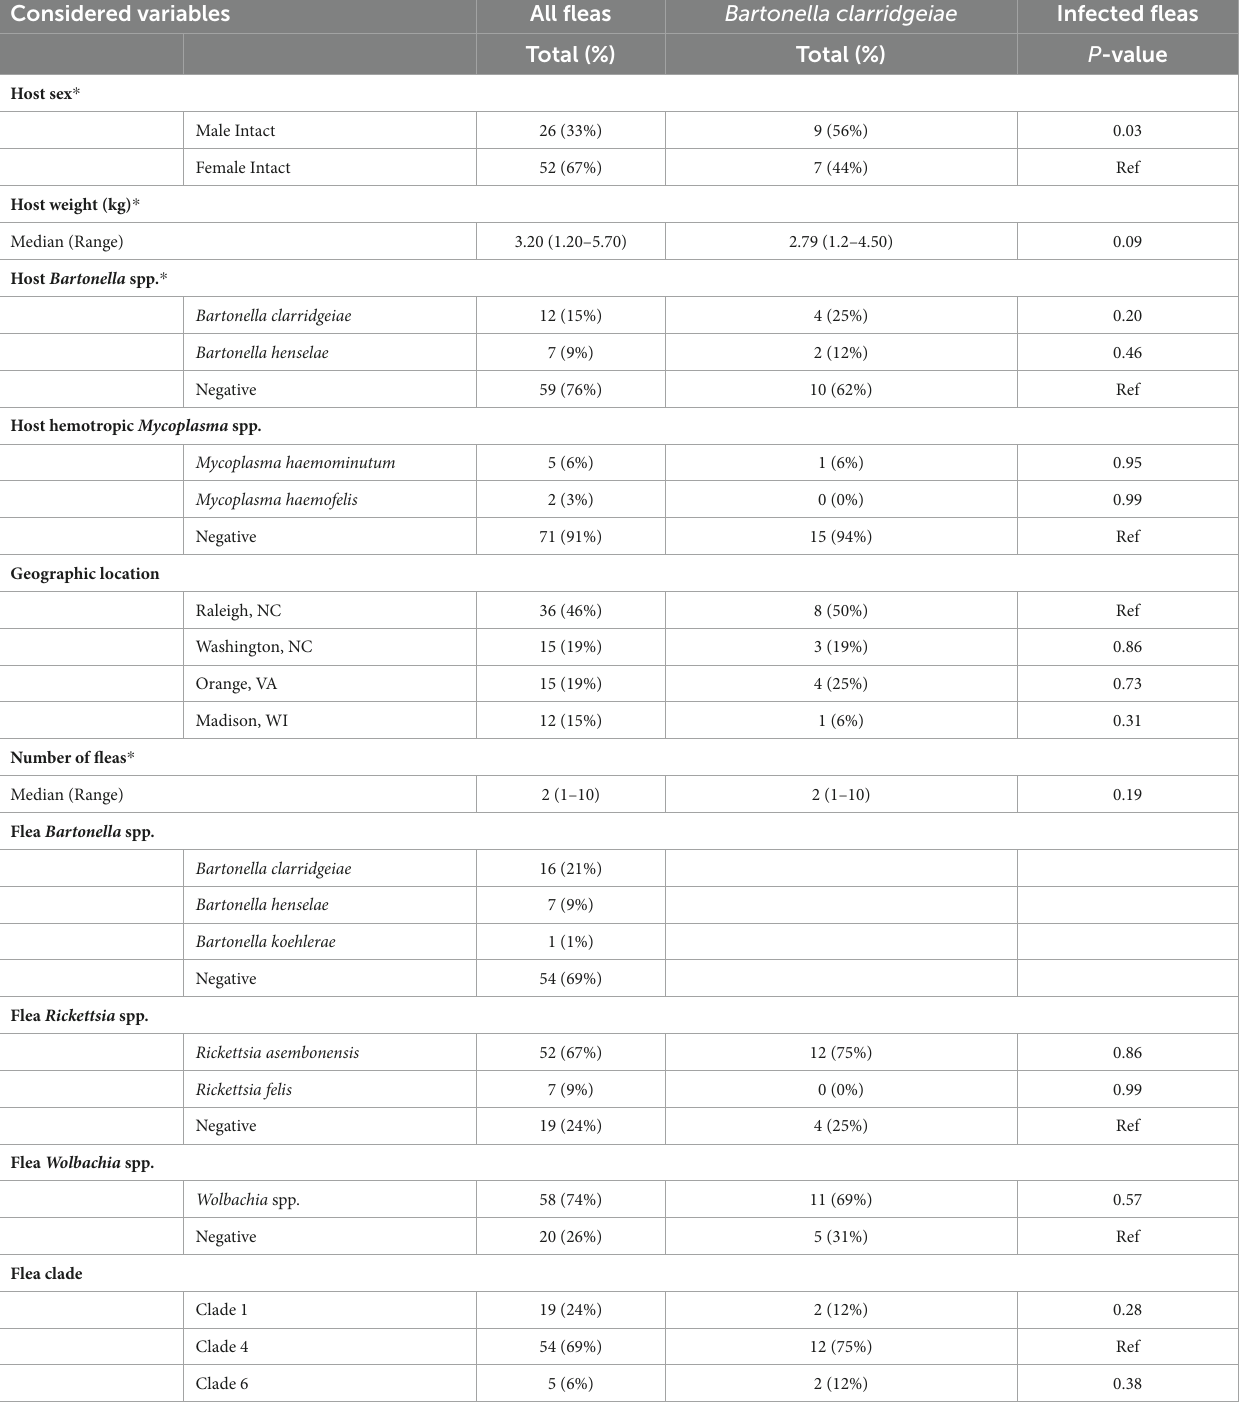
TABLE 3 Summary of the variables considered for inclusion in the flea B . clarridgeiae model. Considered